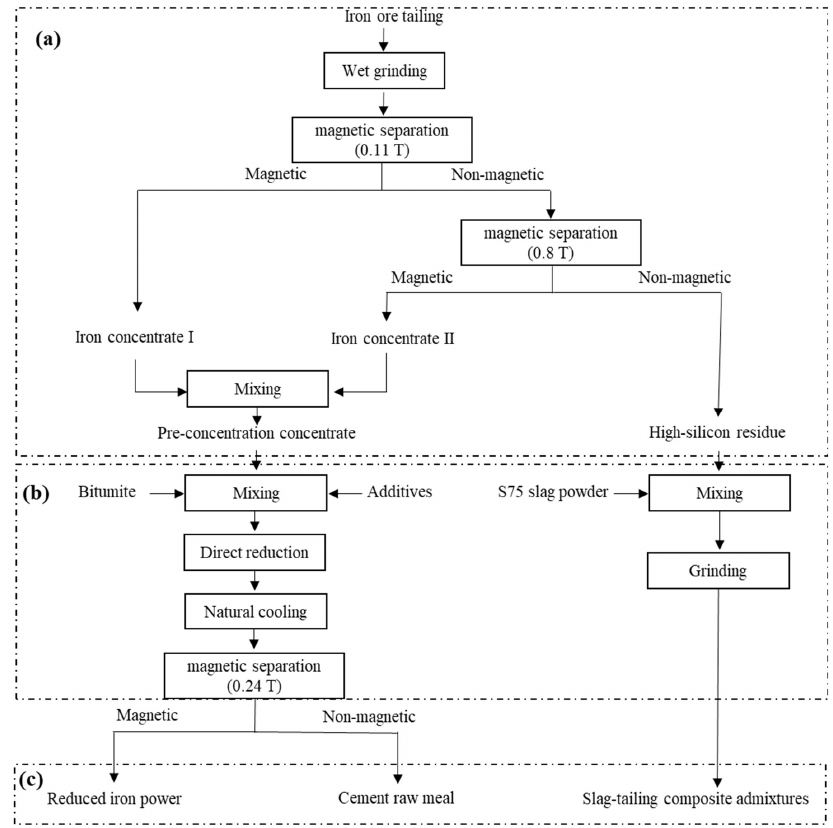
Figure 2. Experimental flowsheet: ( a ) The process of pre-concentration; ( b ) the process of iron recovery; ( c ) final products.